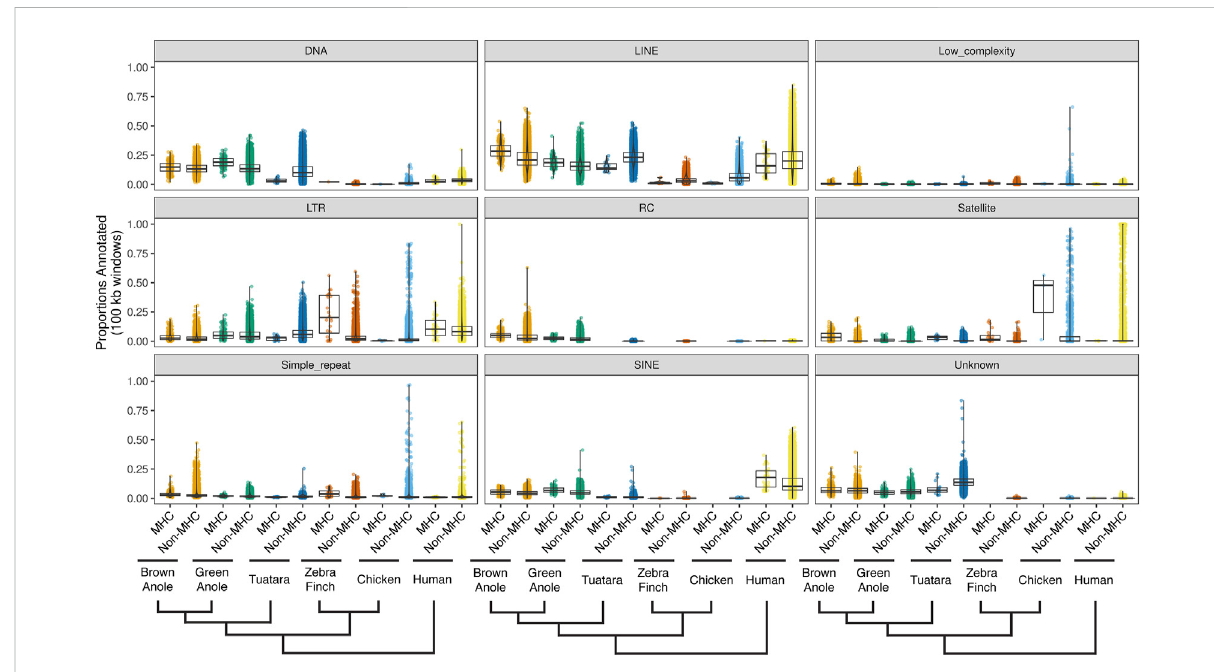
FIGURE 6 Quantitative summary of repeat element compositions across MHC and non-MHC regions of six amniote species. For each of nine major classi fi cations of repeat elements, per-species distributions of the proportions of non-overlapping 100 kb windows were calculated for MHC and non-MHC regions. Species are arranged phylogenetically along the x -axis with a phylogeny that summarizes their evolutionary relationships. See SupplementaryFigureS10fortheresultsofpairwisestatisticalcomparisonsbetweeneachrepeatclassi fi cation,genomicregion(MHCandnon- MHC), and amniote species. See Supplementary Table S11 for the summary statistics underlying repeat proportion distributions and the results of pairwise statistical comparisons between each repeat classi fi cation, genomic region (MHC and non-MHC), and amniote species. Abbreviations for repeat elements are as follows: DNA = DNA transposons, LINE = Long Interspersed Nuclear Element; LTR = Long Terminal Repeat elements; RC = Rolling Circle elements; and SINE = Short Interspersed Nuclear